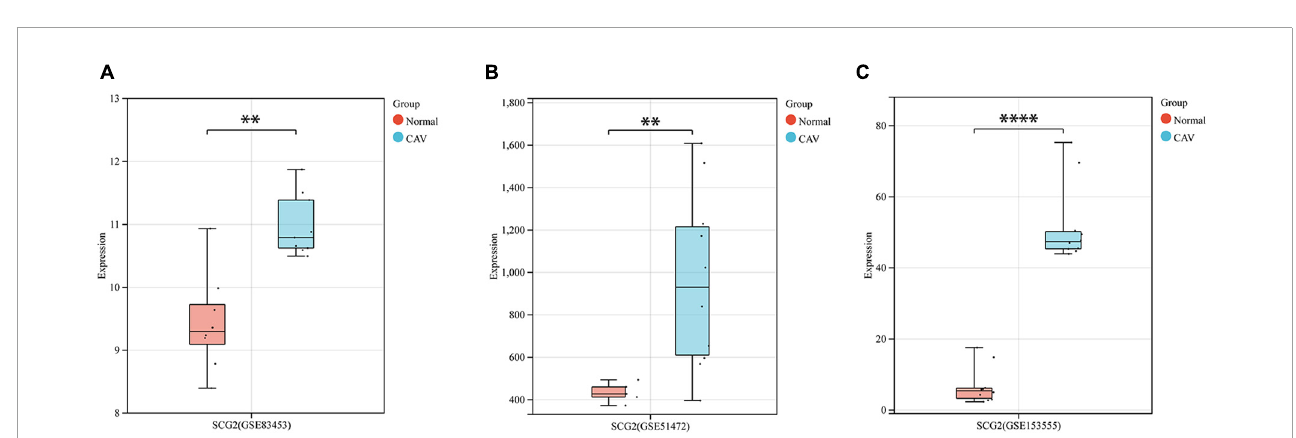
FIGURE3 Boxplots represent the gene expression levels of calcified samples compared to normal samples in the three datasets. (A) GSE83453, (B) GSE51472, (C) GSE153555. Wilcoxon rank-sum test, normal, control; CAV, calcified aortic valve. ∗ p < 0.05, ∗∗ p < 0.01, ∗∗∗∗ p <